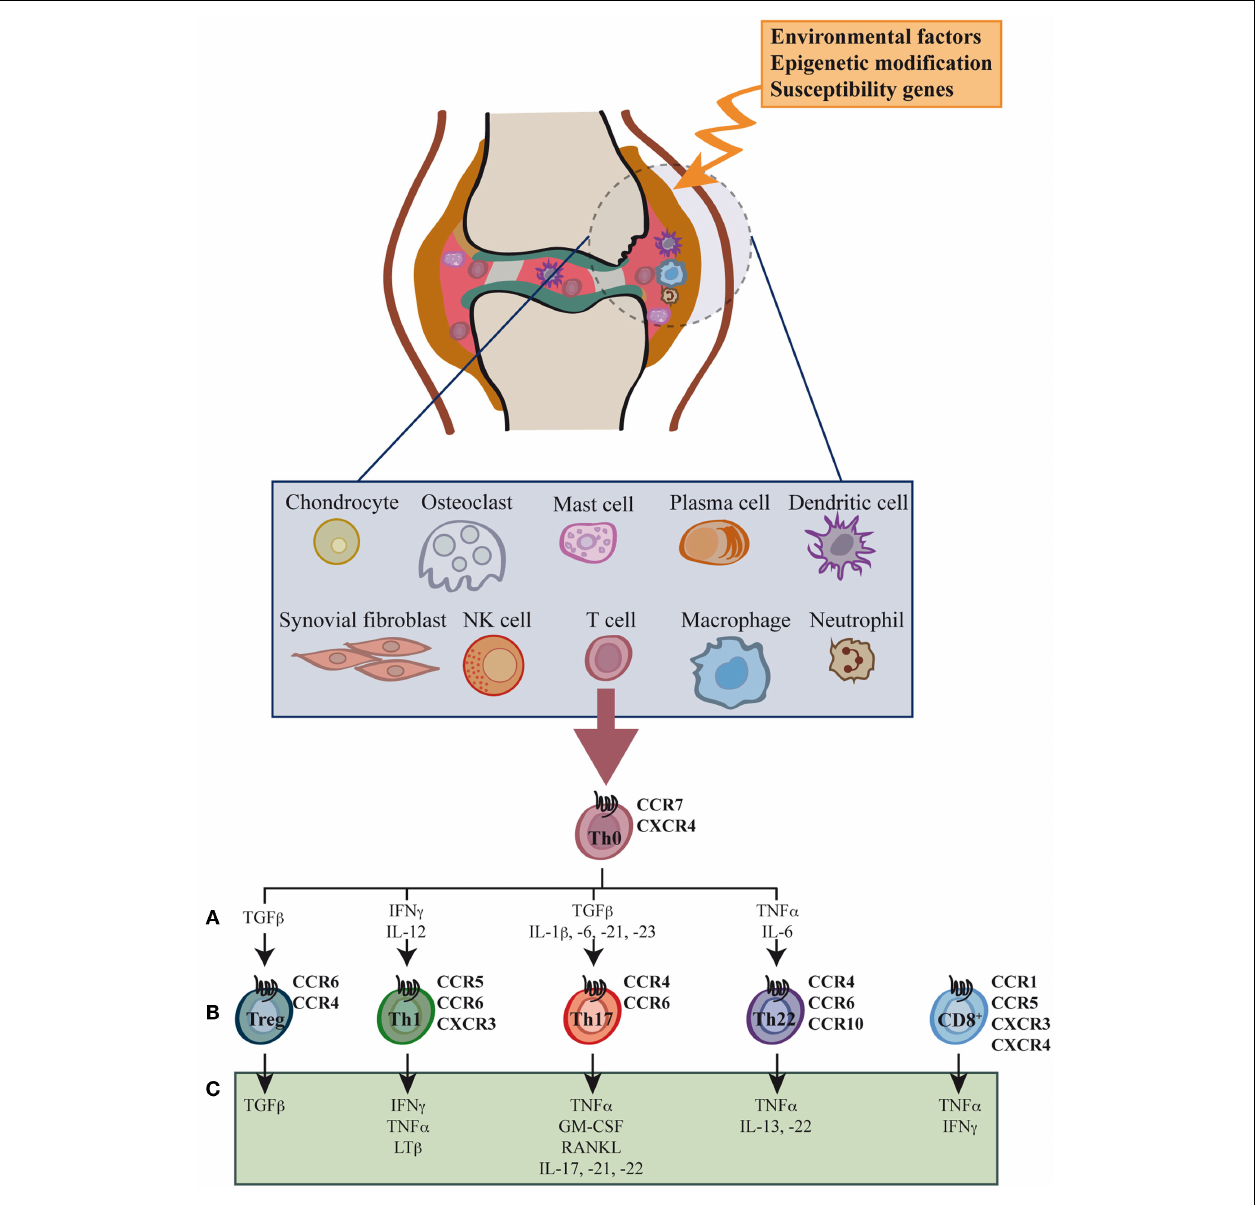
with the molecular products of damage, drive the chronic phase in rheumatoid arthritis (RA) pathogenesis. High levels of activated memory CD4 + and CD8 + T cells differentiated through cytokine stimulation of naïve cells infiltrate the synovia (A) . RA was classically considered a type 1 T helper (Th1)-mediated disease, but today data indicate that type 17 T helper cells (Th17) are more important in its promotion. Evidence shows that type 22 T helper cells (Th22) also contribute to RA pathogenesis. Function of regulatory T cells (Treg) is also reduced and effector cell resistance to suppression thus helps to alter the immune balance in inflamed joints. The figure shows the chemokine receptor expression pattern (B) and the main secreted cytokines (C) associated with each T cell